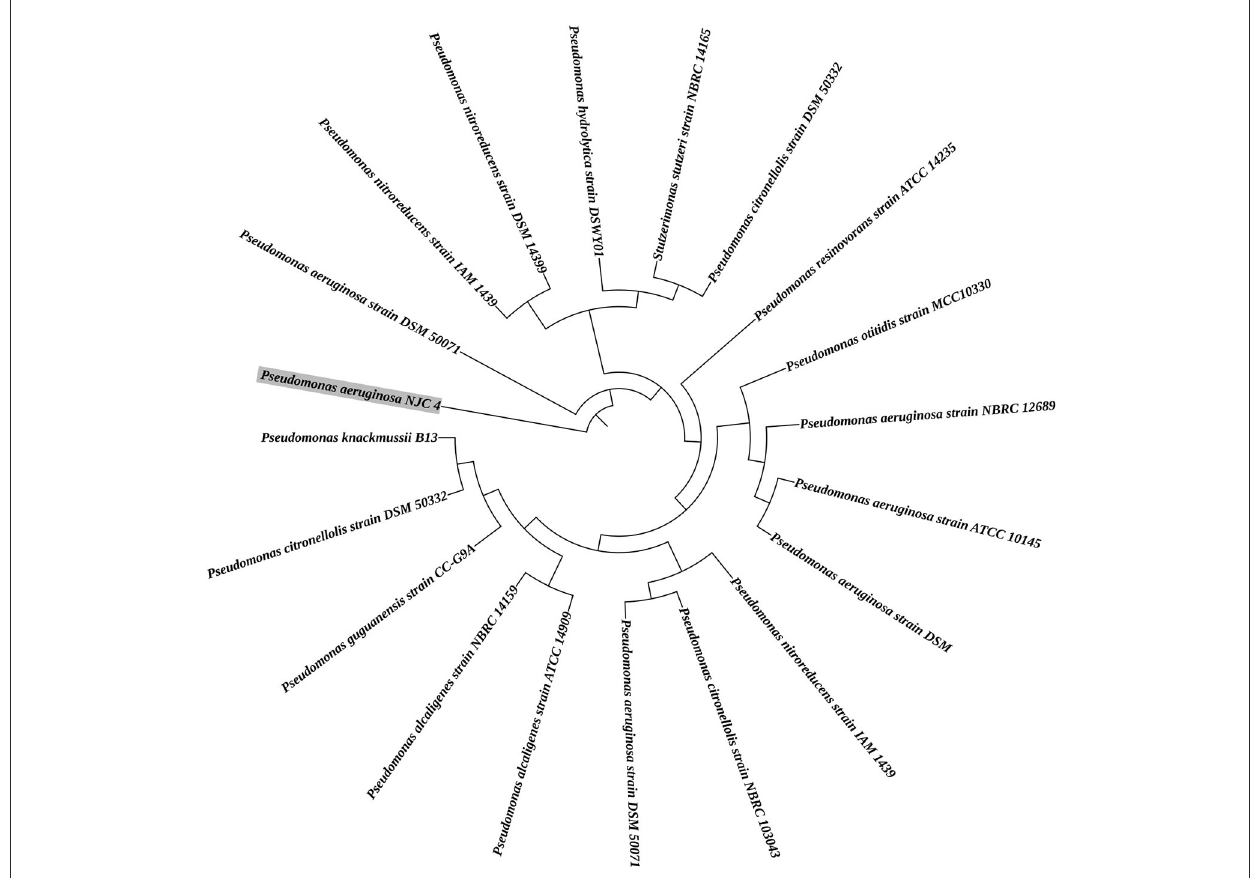
FIGURE2 Phylogenetic tree of Pseudomonas aeruginosa- NJC